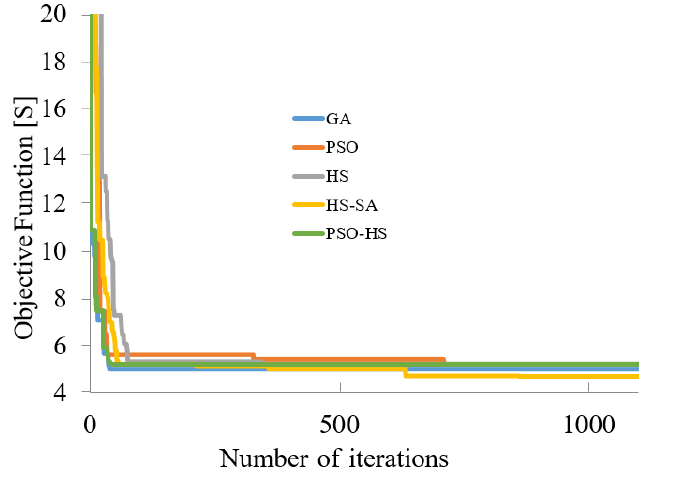
Figure 4. Convergence of different algorithms for Scenario